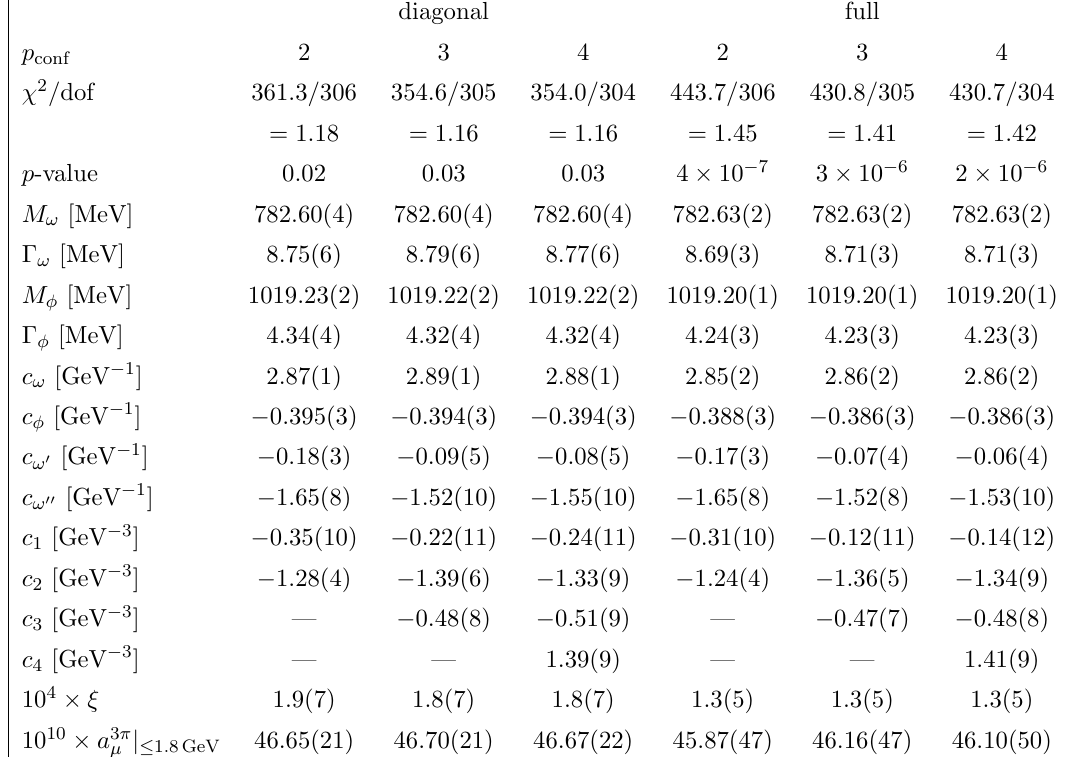
Table 6 . Fits to the combination of SND [69{72], CMD-2 0 [63, 73{75], BaBar [68], DM1 [76], and ND